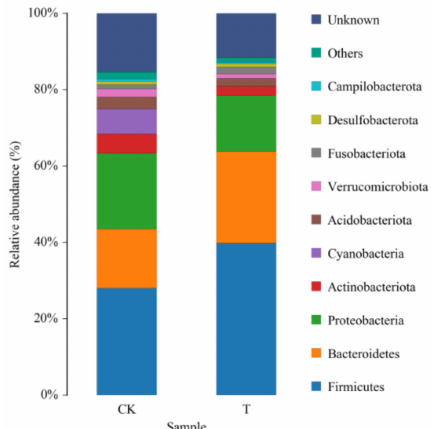
Figure 4. Histogram of the relative abundance of top 10 phyla of the gut microbiota samples of Grapholita molesta before and after antibiotic feeding. CK: control; T: treatment with ciprofloxacin. Each color represents a species, and the height of the color block indicates the proportion of the species in relative abundance. Other species are incorporated as “Others” shown in the diagram. “Unknown” represents species that have not received a taxonomic